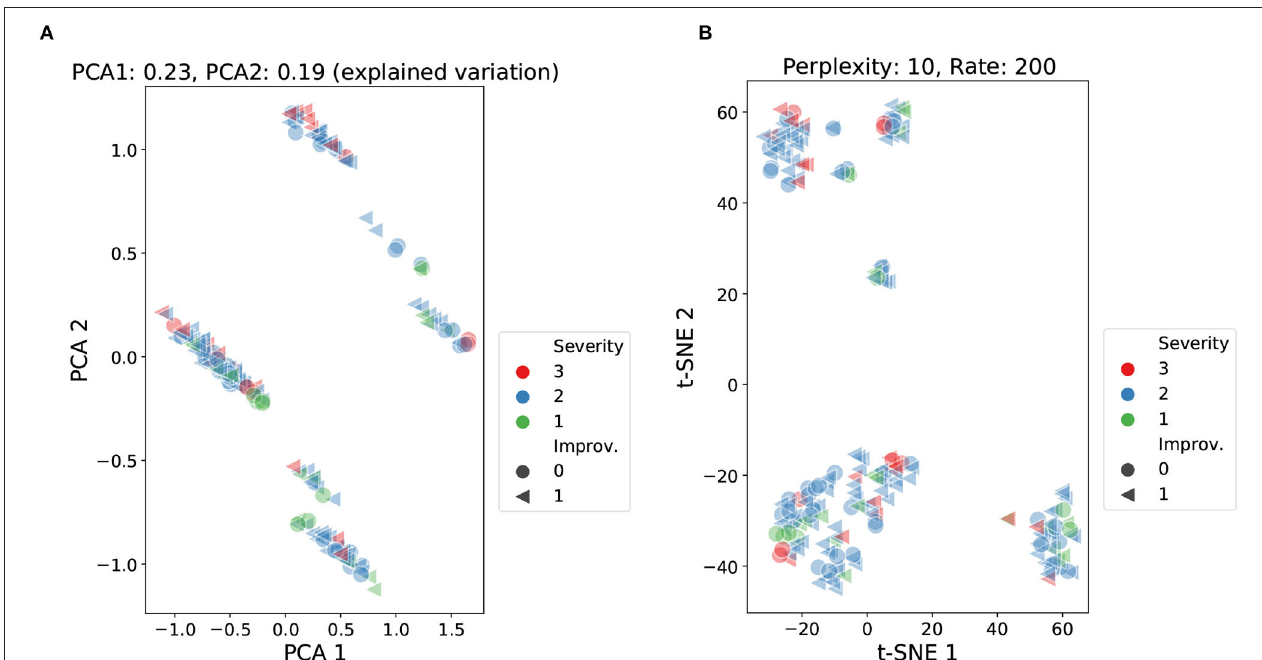
FIGURE 4 | Cluster analysis using PCA and t-SNE over demographic, cognitive, and therapy variables. Data points labeled according to severity (NIHSS score) and improvement ( global improvement ). PCA: accumulated explained variance 0.42 (A) . t-SNE: perplexity 10, learning rate 200 (B) .